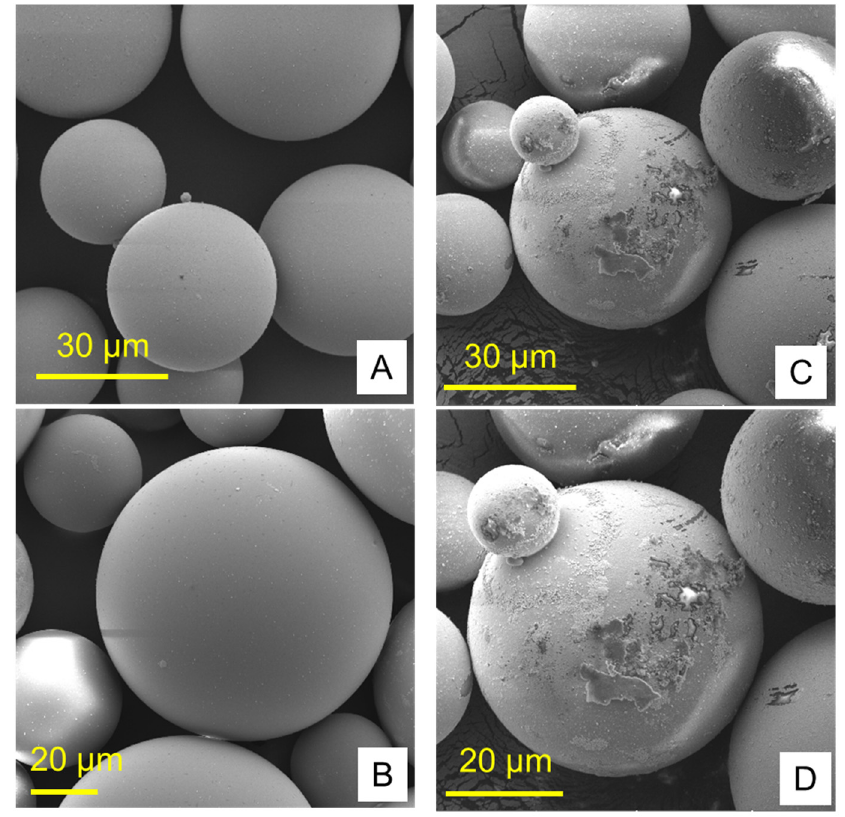
Figure 2. Scanning electron micrographs of ( A , B ) pure PMMA and ( C , D ) PMMA/ND mixture at two magnifications.